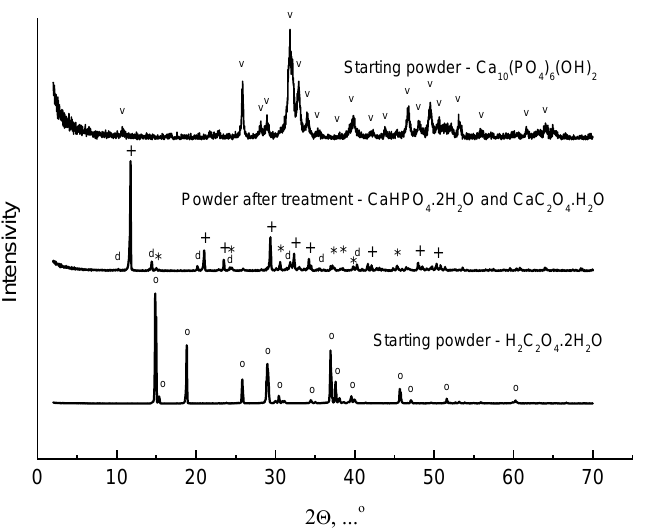
Figure 1. XRD data for starting components and resulting powder mixture: v—Ca 10 (PO 4 ) 6 (OH) 2 (PDF card 9-432); o—H 2 C 2 O 4 · 2H 2 O (PDF card 14-832); +—CaHPO 4 · 2H 2 O (PDF card 9-77); *—CaC 2 O 4 · H 2 O (PDF card 20-231); d—CaC 2 O 4 · H 2 O (PDF card 17-541).